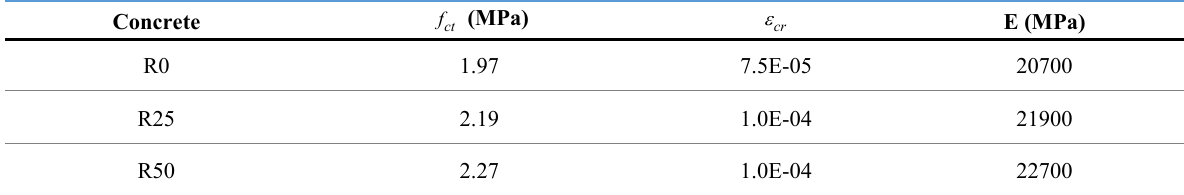
Table 4. Concrete properties obtained in the tension stiffening